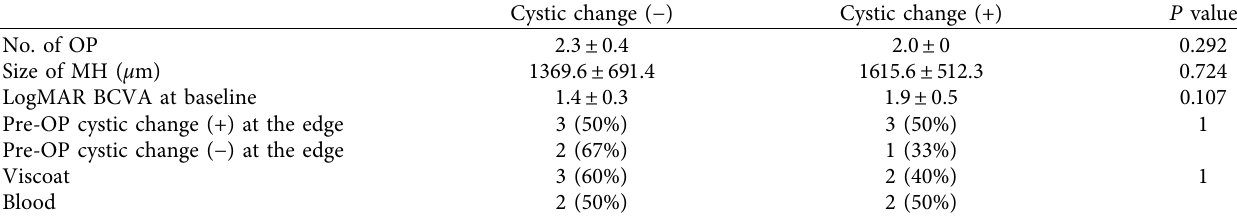
Table 3: Preoperative parameters between the eyes with or without macular cystic change.